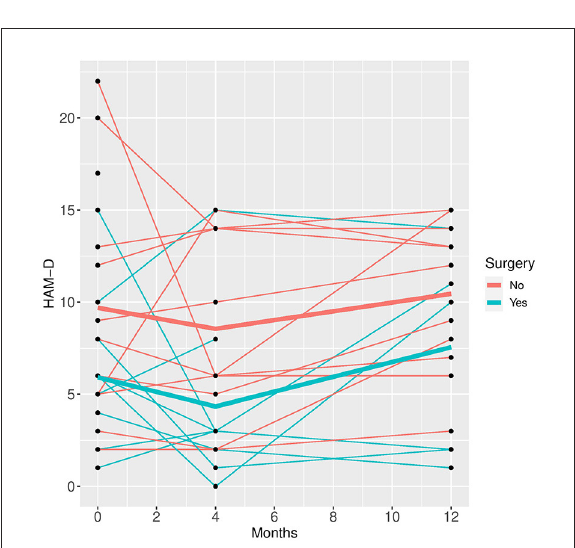
FIGURE2 BDI time course for individual patient data (thin lines) and averaged values (bold